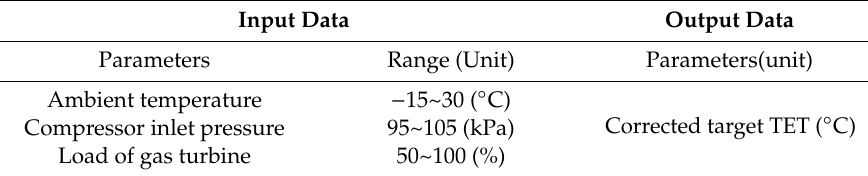
Table 2. Variation ranges of parameters for making database for black box model 1.